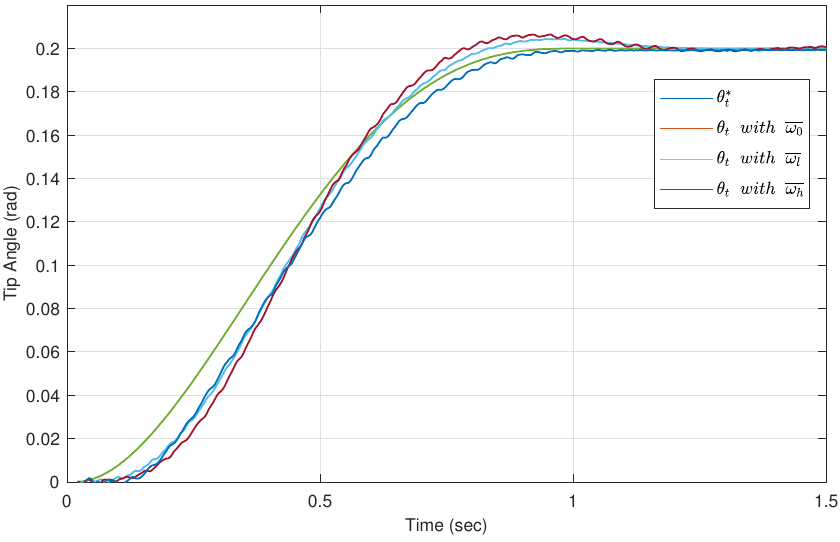
Figure 14. Experimental tracking of a trajectory using the FPD controller